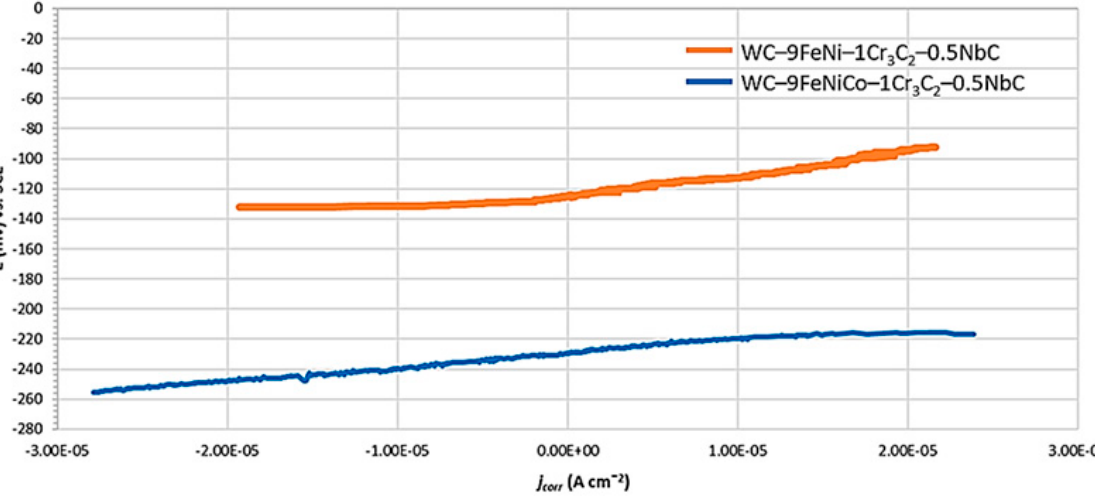
Figure 7. Linear polarization curves of samples.